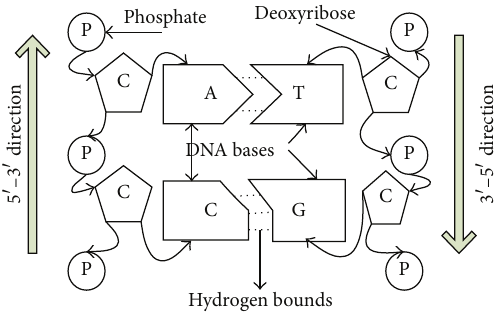
Figure 1: The general structure of the DNA